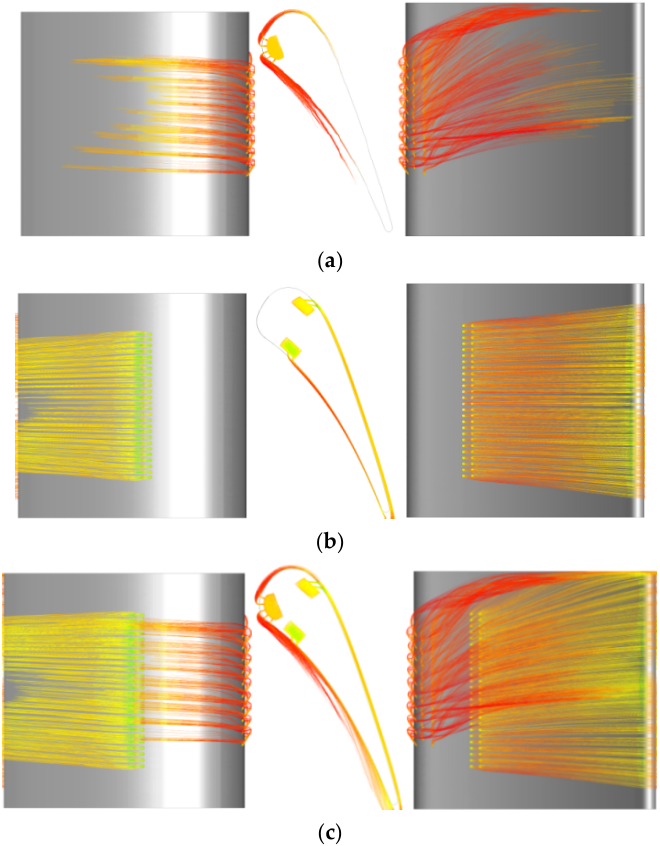
Figure 6. Streamlines distribution comparisons for different cases. ( a ) uncoated vane with LE film, ( b ) uncoated vane with downstream film, ( c ) uncoated vane with LE and downstream film.